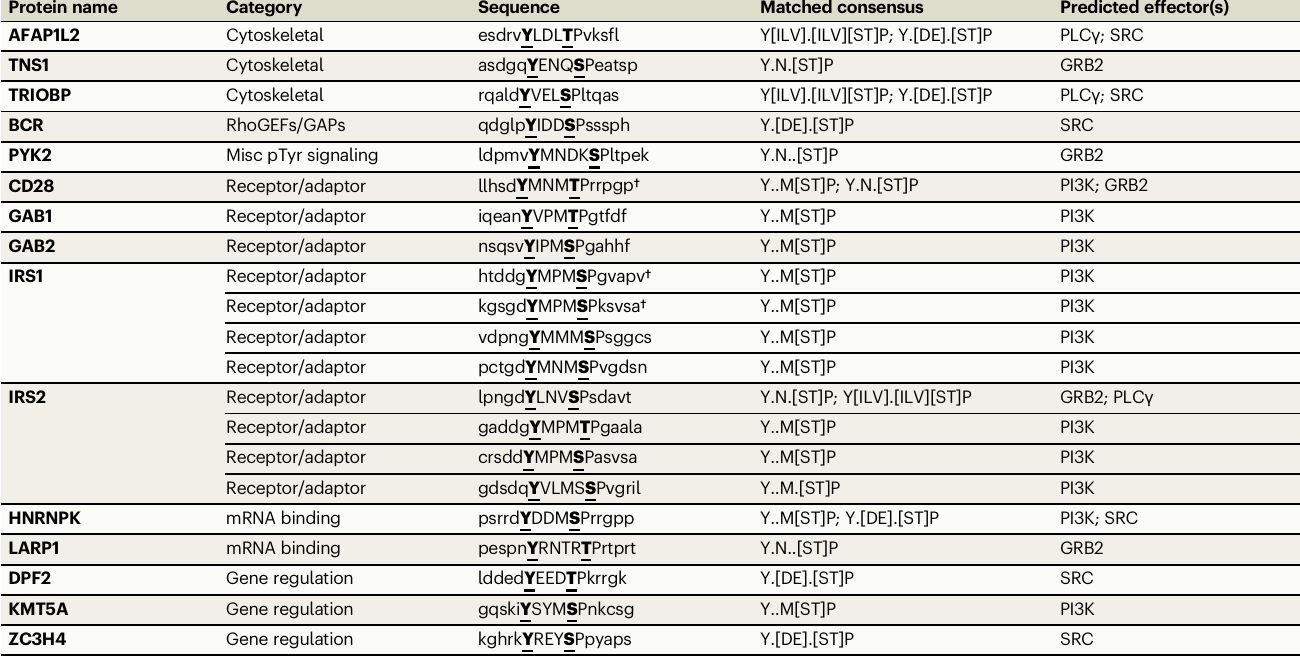
Table 2 | Prediction of pSer/pThr modulated SHP2 target pTyr motifs Protein